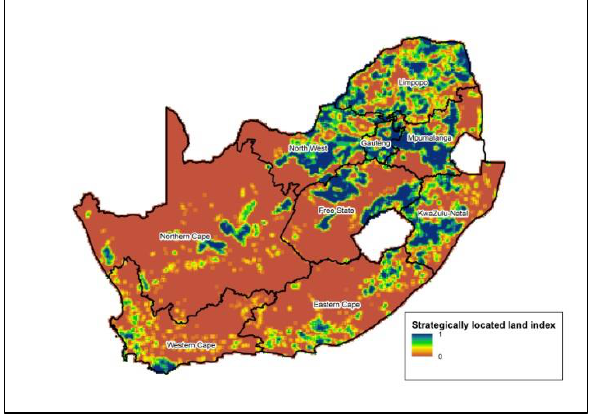
Figure: Strategically located land index, South